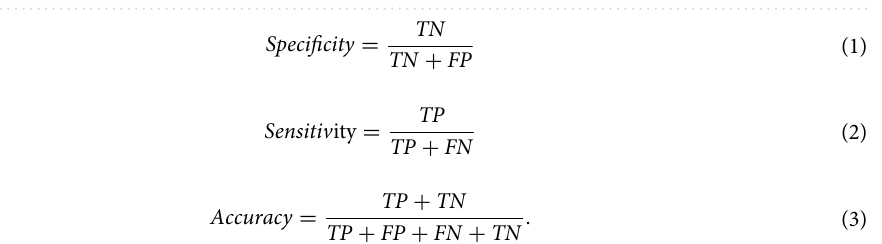
Figure 3. SVC parameter selection result (3D